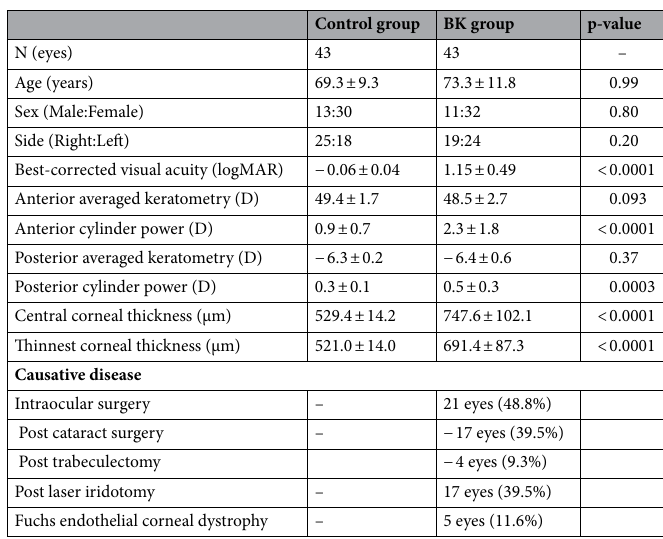
Table 1. Demographic characteristics, BCVA and AS-OCT measurements of control and BK